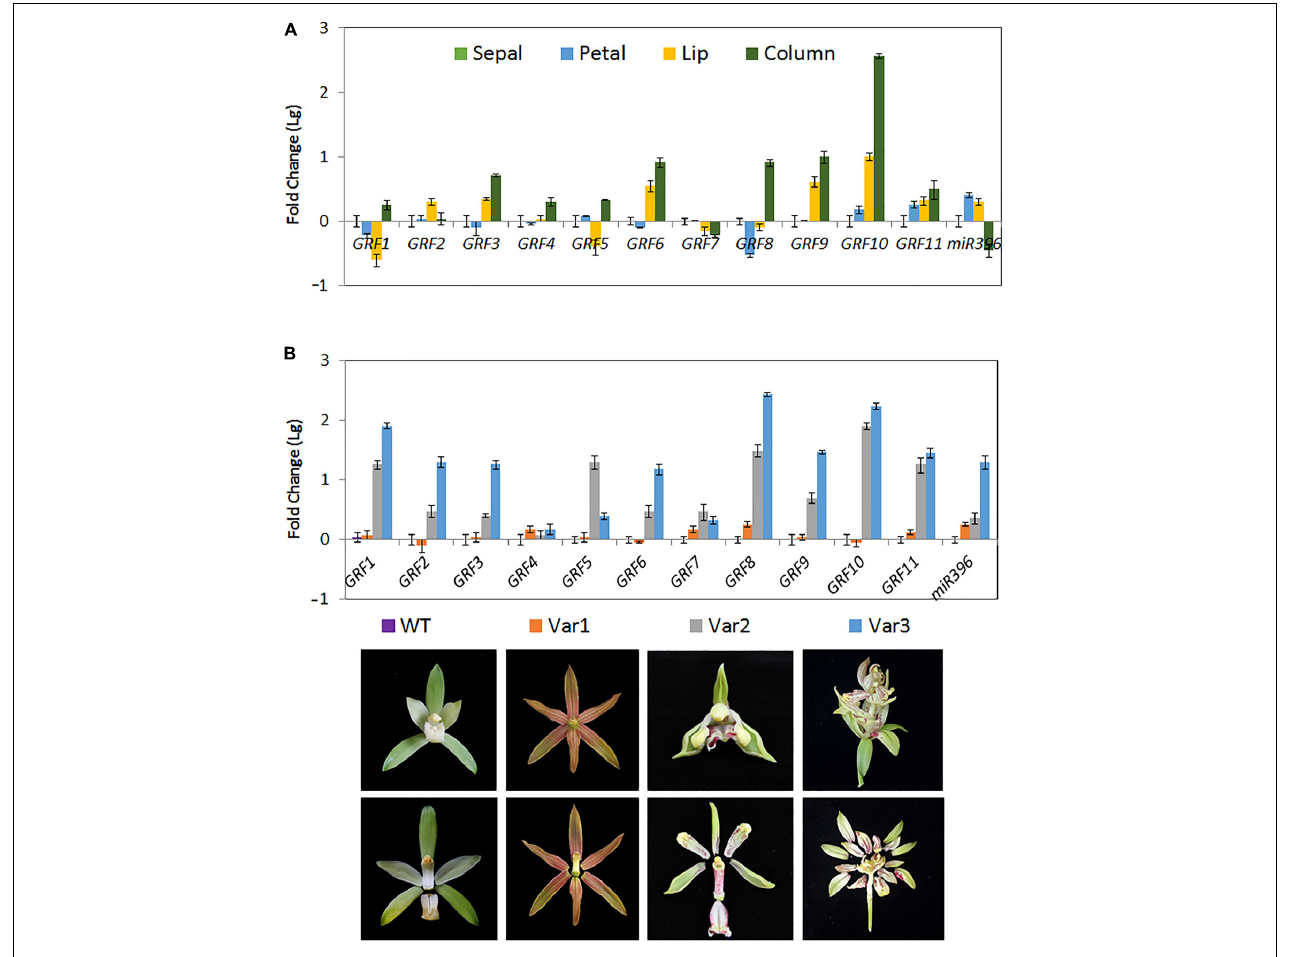
FIGURE 7 | Expression of Ce -miR396/ CeGRF Correlates with Flower Development. Expression of CeGRF genes and Ce- miR396 in different floral organs examined by RT-qPCR and stem-loop PCR, respectively. We analyzed individual floral organs (sepal, petal, lip, and column) (A) and the whole flowers of three floral varieties that develop non-lip (Var1) or stamenoid-tepal (Var2) or multi-tepal flowers (Var 3) (B) . The Y-axis indicates fold change (Log value) in expression among different floral organs. Expression levels were normalized using the threshold cycle values obtained for the Ubiquitin gene. The samples from sepal and the wild-type flower (WT) were used as a standard to present fold change (Lg). Error bars indicate the standard deviation of the mean (SD) ( n = 3). Three replicates were analyzed, with similar